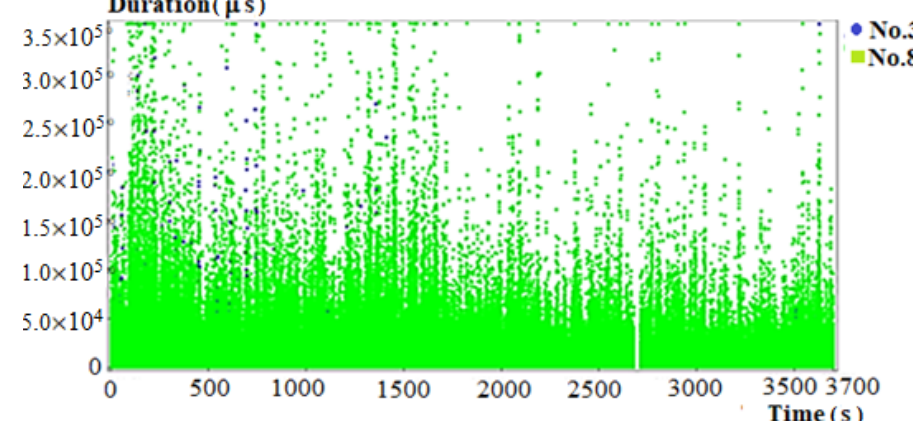
Figure 12. Energy versus time for sensors 1–12 on column 2 with the numbers of signal classes marked.